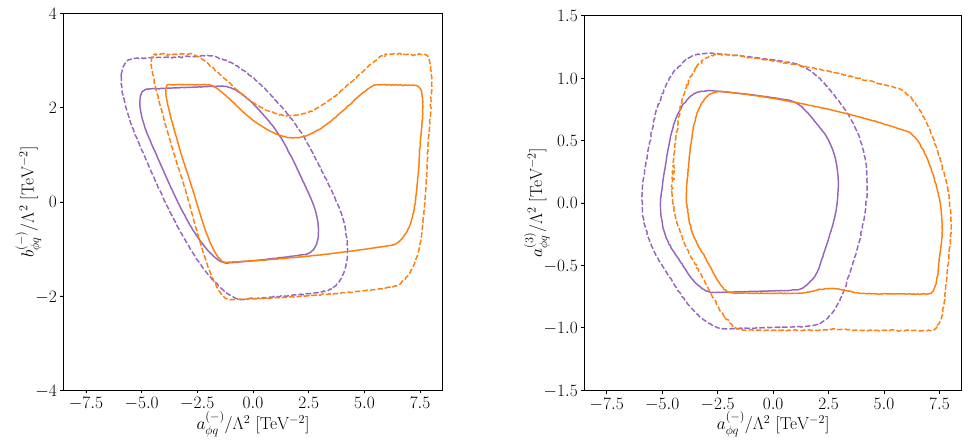
( m ) = C (1) and C (3) ( m ) to t ¯ tZ − C (3) t t φq φq φq φq , b ( − ) , a (3) , b (3) } to top observables with (orange) and φq φq φq φq are also included in + µ − and B → X s → µ s γ